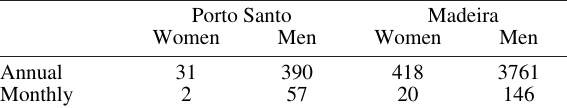
Table 1. – Recreational shore angling licences in Madeira grouped by island, sex and licence duration in 2017 (Regional Directorate of Fisheries).